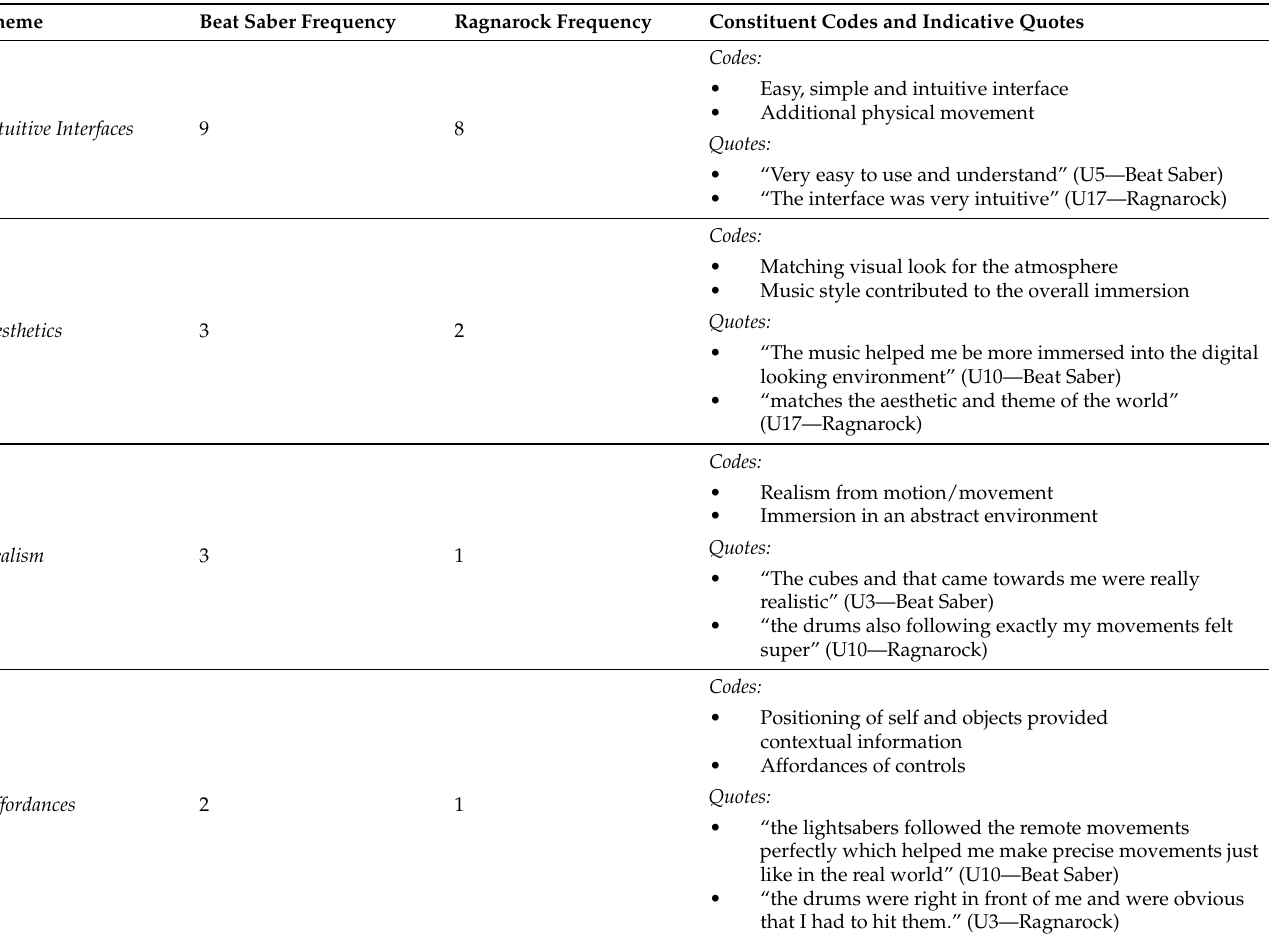
Table 6. Frequency of themes per game relating to user interfaces and experience, with illustra- tive